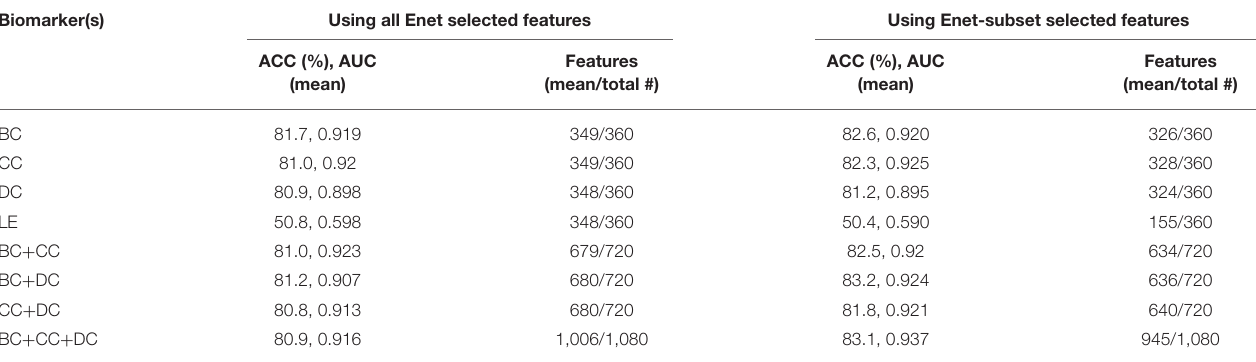
TABLE 3 | A summary (mean of 100 iterations) of the classification accuracy and AUC using the Enet and proposed Enet-subset feature selection methods. Biomarker(s) Using all Enet selected features Using Enet-subset selected features